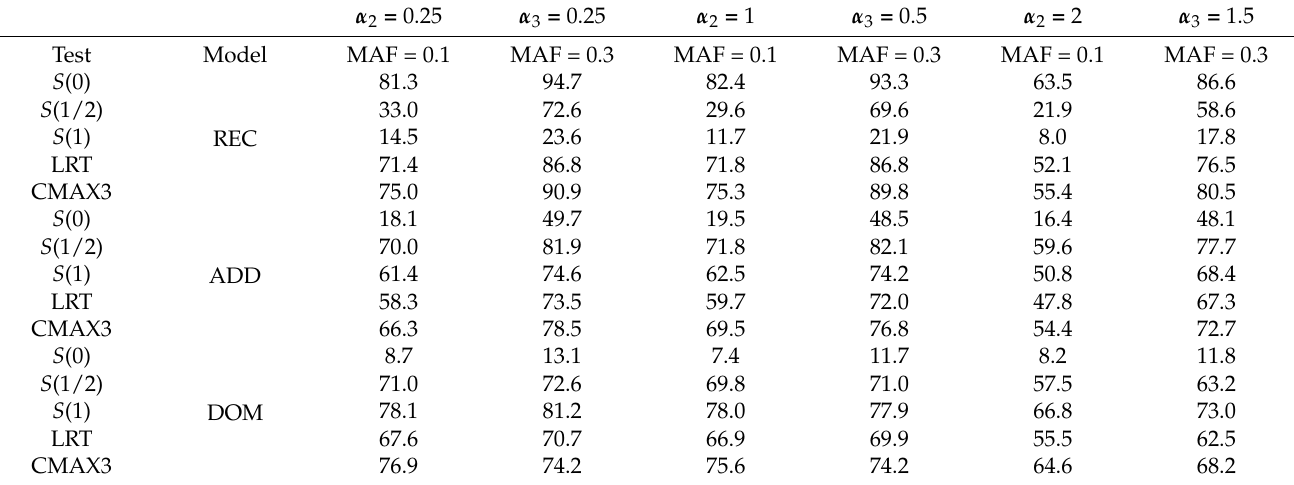
Table 3. Empirical powers from simulation study using sample size 2000 and nominal level 5%.